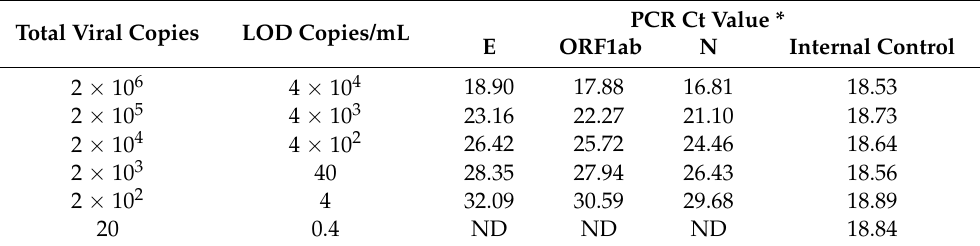
Table 3. The PCR Ct results of six wastewater samples spiked with Delta virus isolate with a final viral load between 40,000 to 0.4 copies/mL. Total Viral